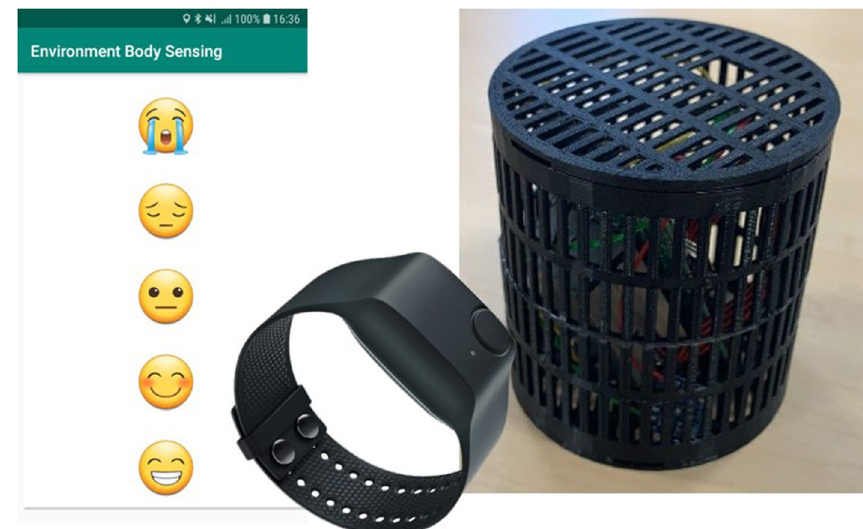
Fig. 5 (left) Screenshot of smartphone application, (middle) E4 Empatica, (right) Environment monitoring